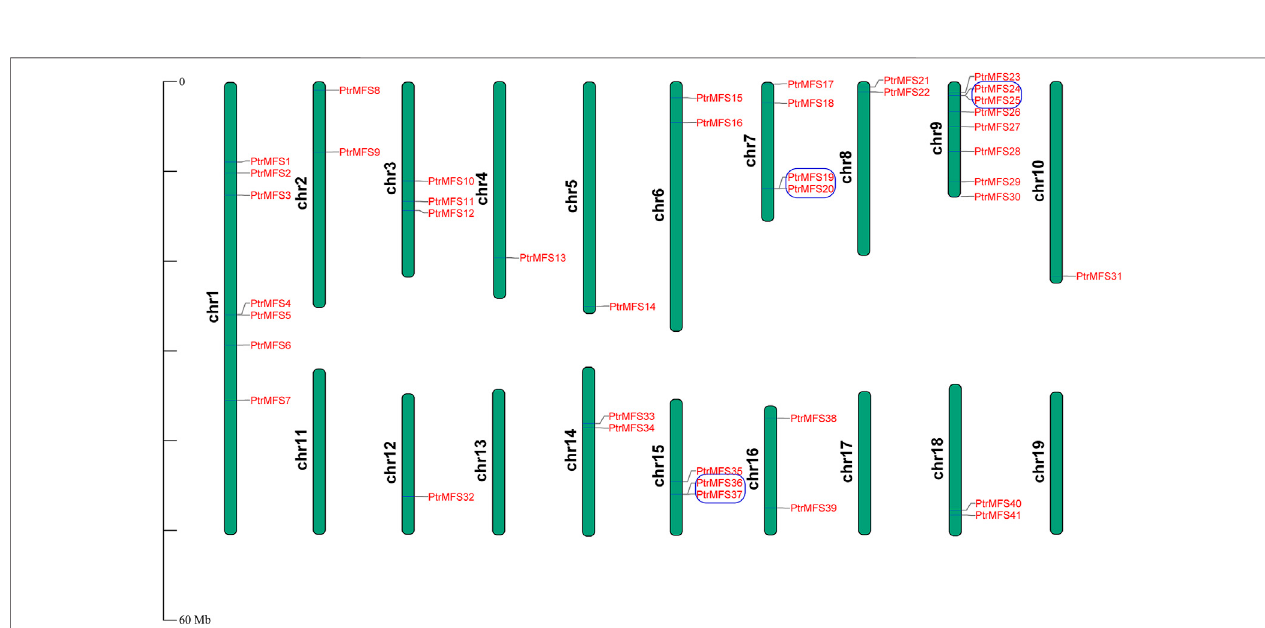
FIGURE 5 | Chromosomal distribution of PtrMFS genes. Chr1 – 19 represent chromosome numbers 1 – 19. Blue boxes represent pairs of tandem repeated genes.